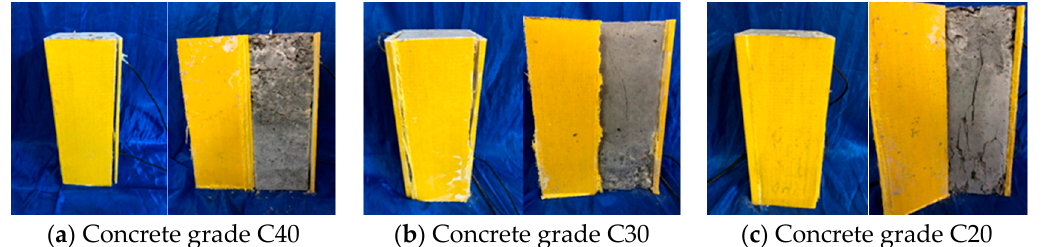
Figure 8. Failure modes of specimens at different concrete grades.